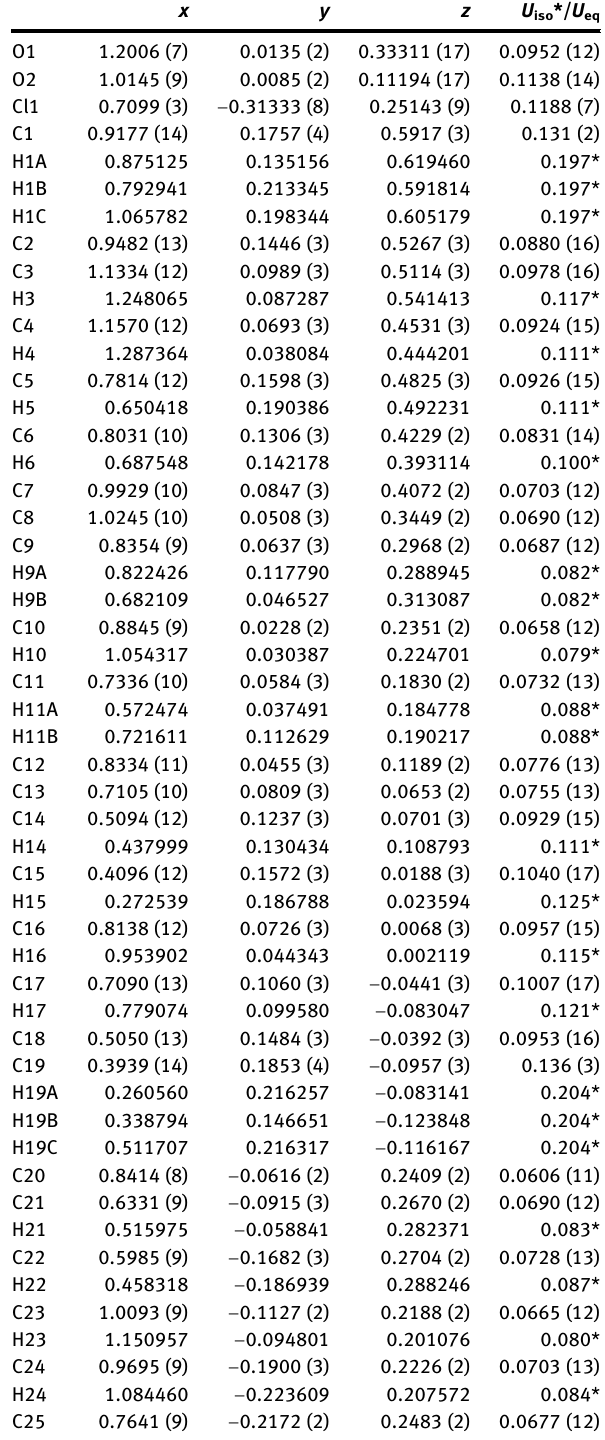
Table  : Fractional atomic coordinates and isotropic or equivalent isotropic displacement parameters (Å 